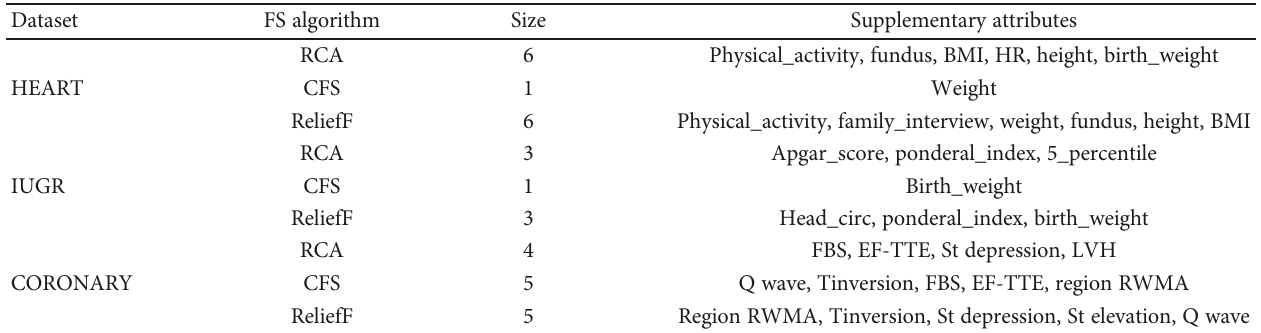
Table 5: Feature selection